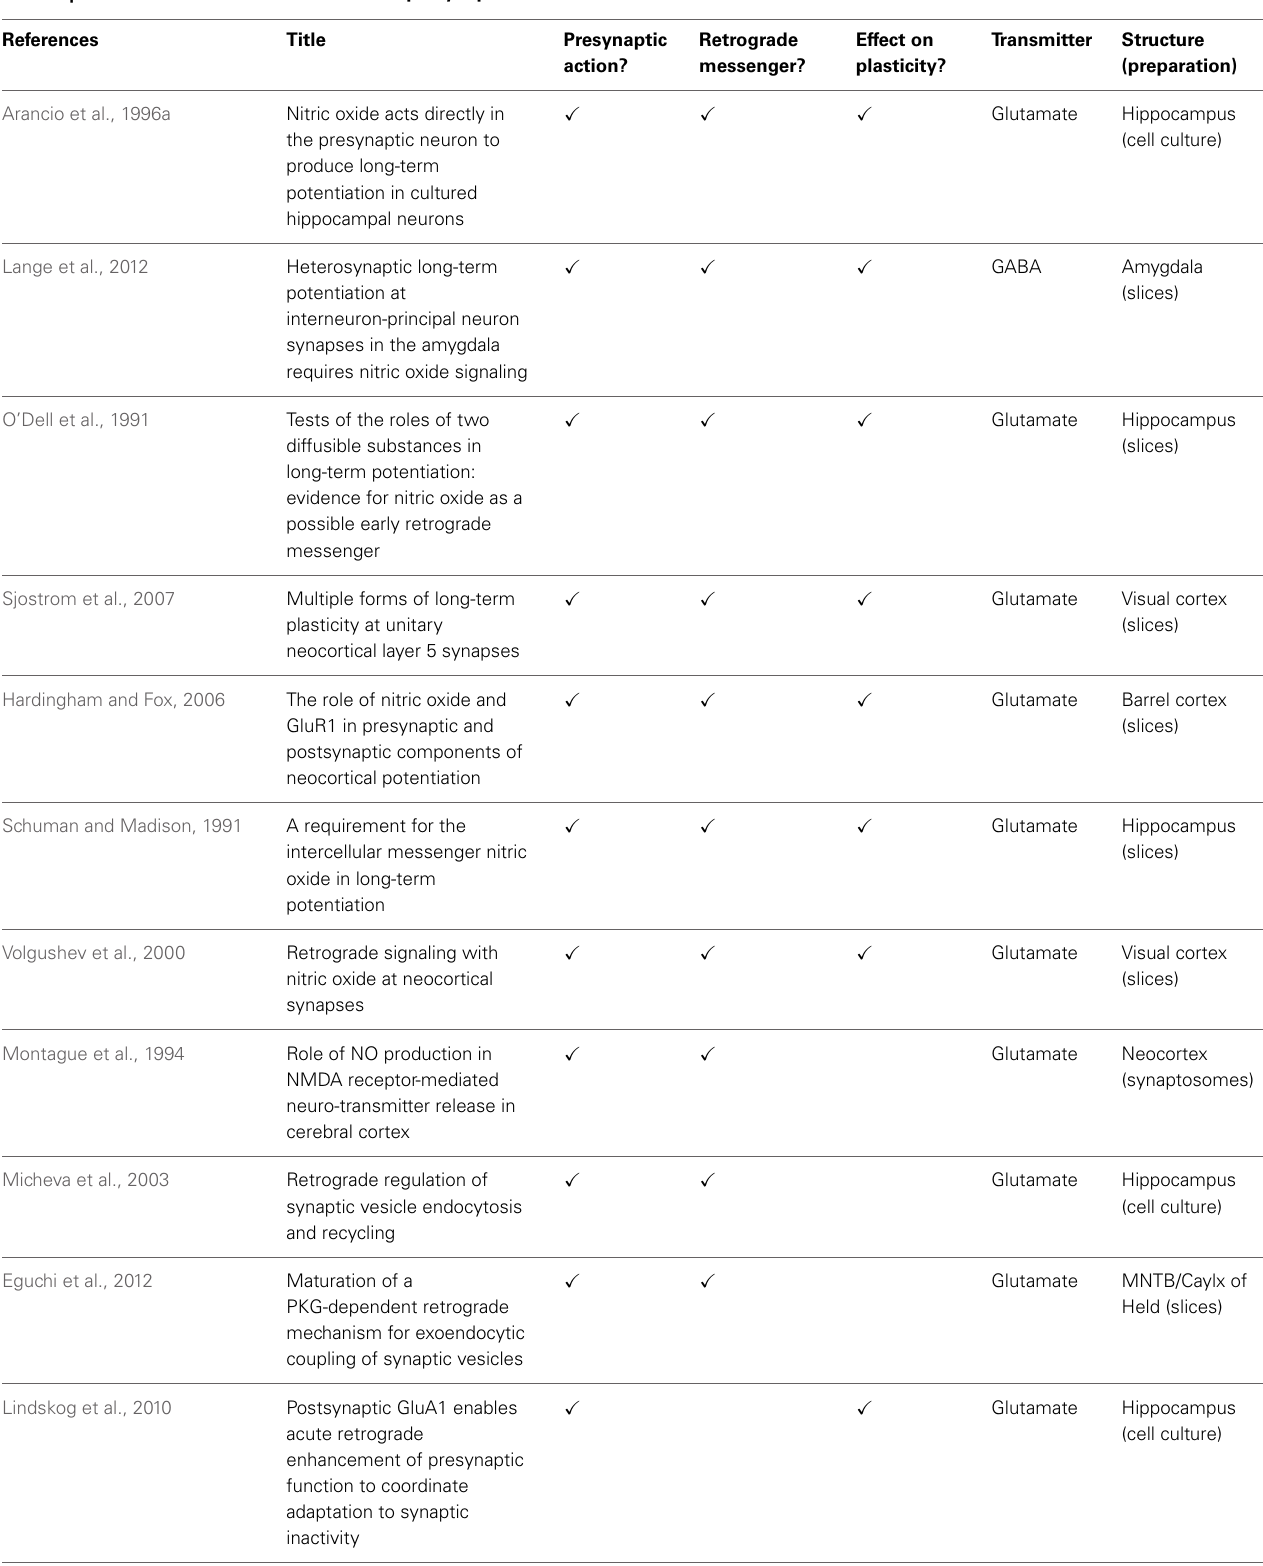
Table 1 | Evidence that nitric oxide influences presynaptic